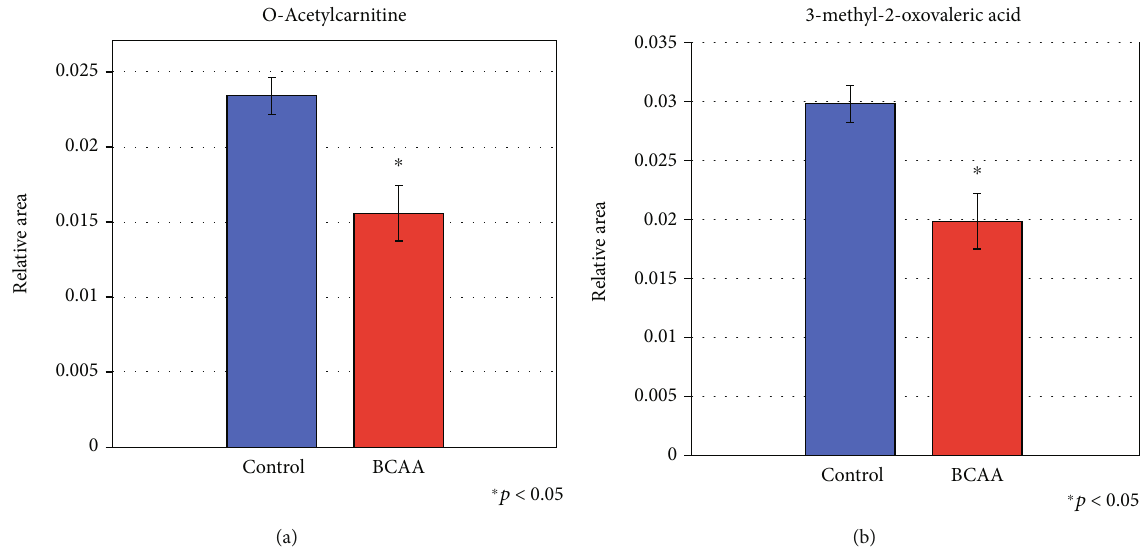
Figure 3: E ff ects of BCAA on the intracellular levels of neuroprotective and neural toxic metabolites. Intracellular levels of ALC (a) and 3- methyl-2-oxovaleric acid (b) were measured and compared with those in the control (no treatment) group. Data are presented as the mean ± SD . n = 3